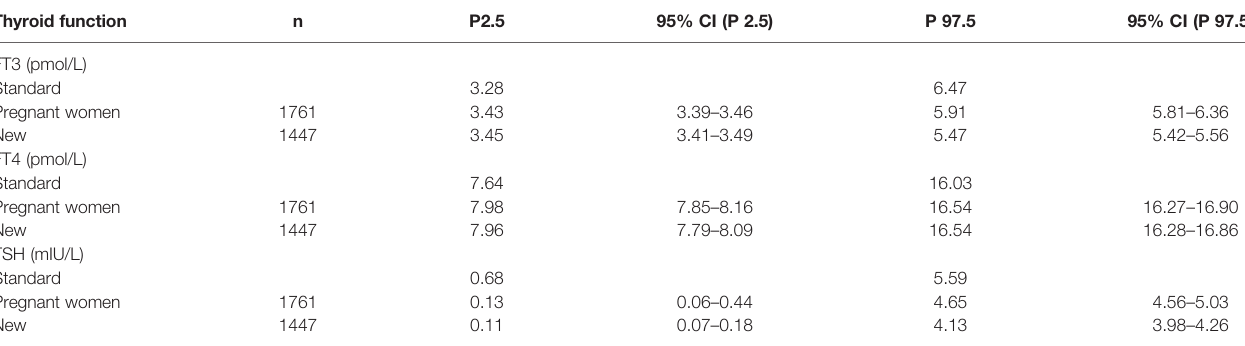
TABLE 2 | Reference ranges of thyroid